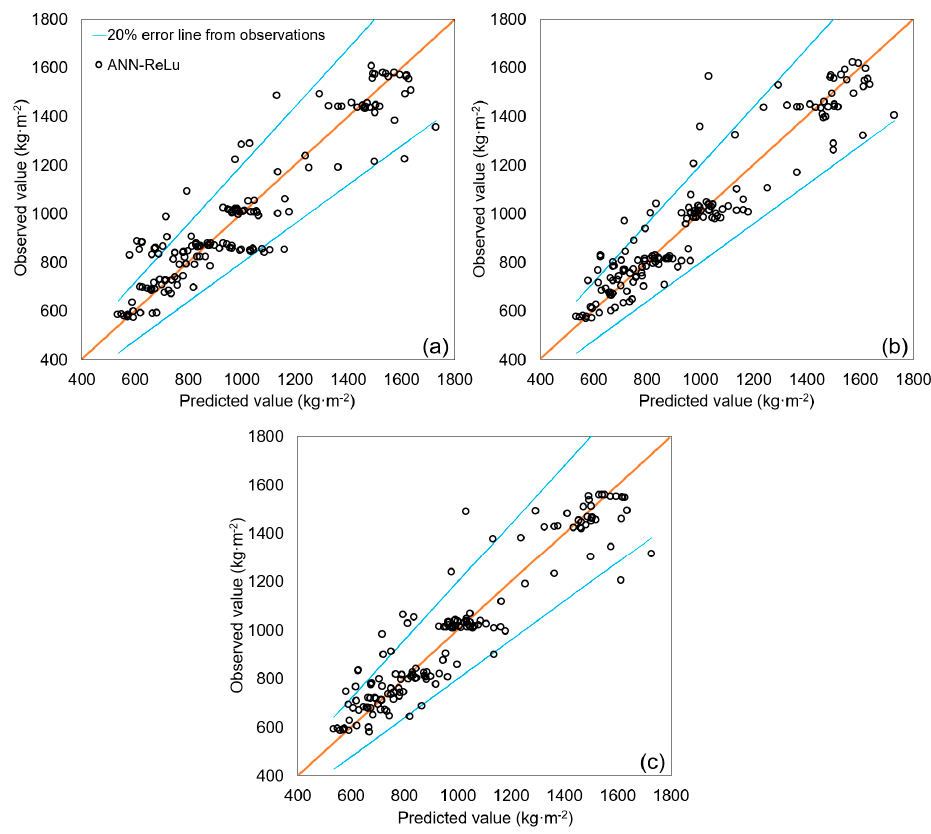
Figure 4. Comparison of the correlation between observed and predicted values: ( a ) ANN − ReLu, ( b ) SVM − polynomial, and ( c ) ANN − Logistic (The blue line in the graph means ± 20% error from the observed value).